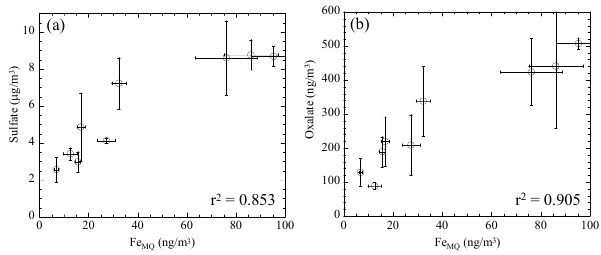
Fig. 11. Relationships of sulfate and oxalate concentrations with atmospheric soluble Fe ([Fe MQ ]). Error bars are standard deviations obtained by three independent